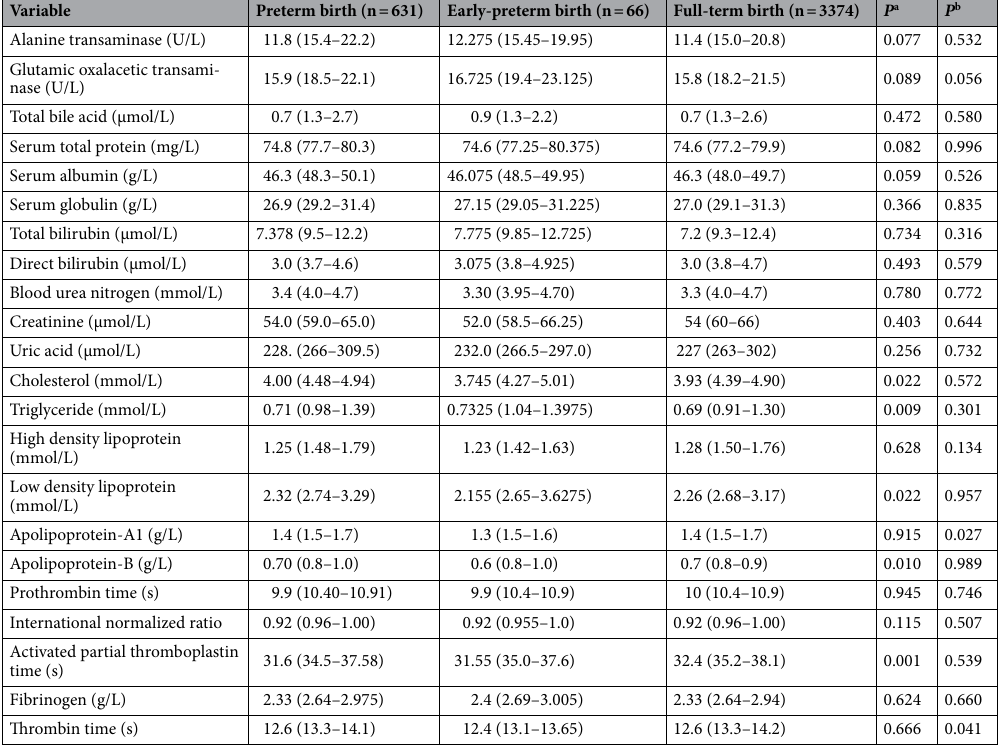
Table 2. Baseline maternal blood test results were compared between preterm birth group and full-term birth group. a Preterm birth group vs. full-term birth. b Early-preterm birth group vs. full-term birth